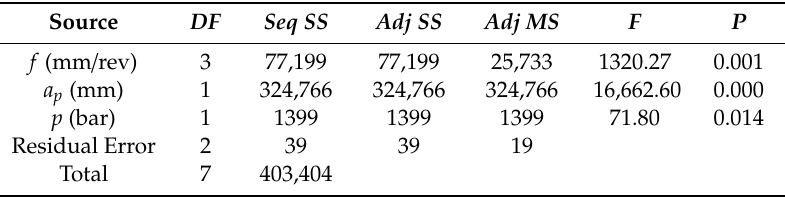
Table 5. Analysis of variance for mean values—main force F c.